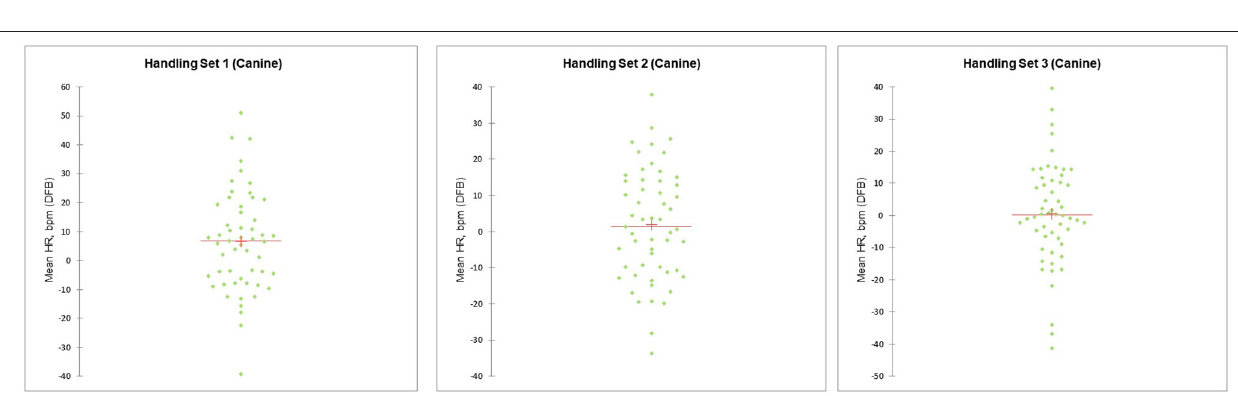
FIGURE 4 | Scatterplot illustration demonstrating individual variation in canine cardiac responses (HR, difference from baseline) to handling, during the three handling sets. The horizontal line on the graphs represents the mean, and can be compared to the “0” point on the y-axis (representing no difference from baseline